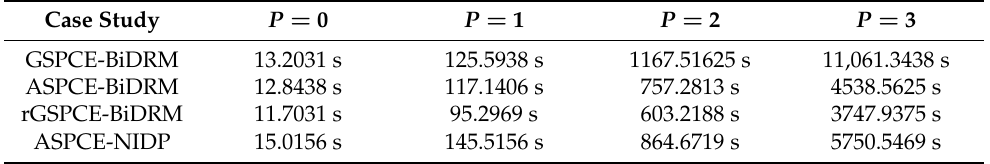
Table 7. Summary of the computational time to quantify uncertainty in model output in Example